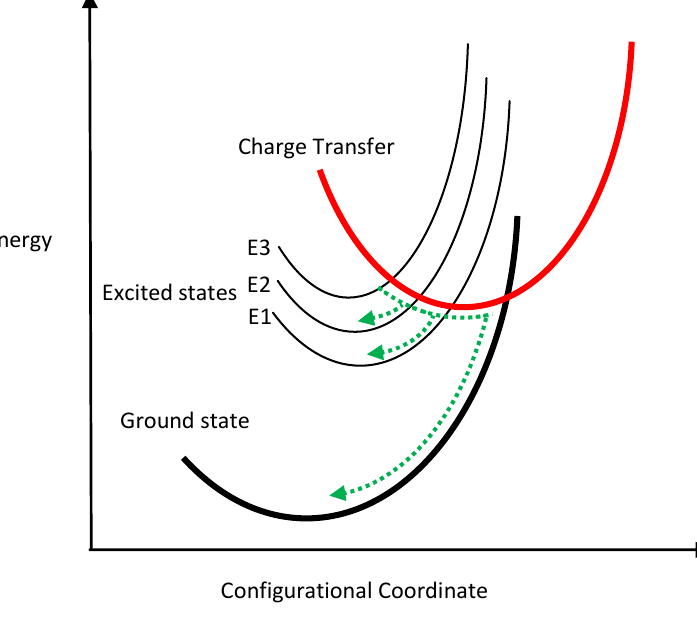
Figure 4. Configuration co-ordinate diagram showing the effect from the charge transfer state (CTS)